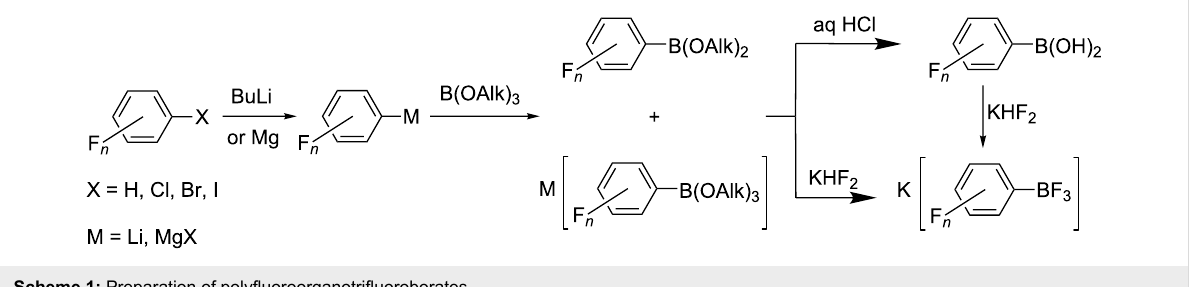
Scheme 1: Preparation of